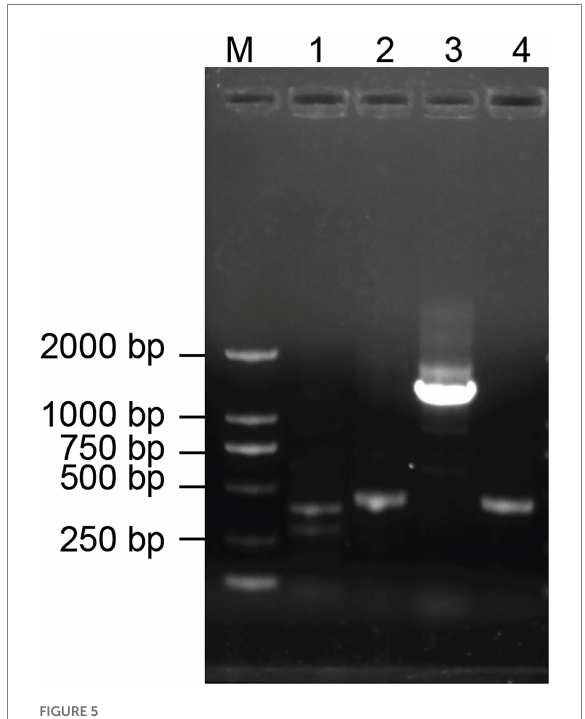
FIGURE 5 PCR analysis of antibiotic biosynthesis genes in strain Pl7. M: